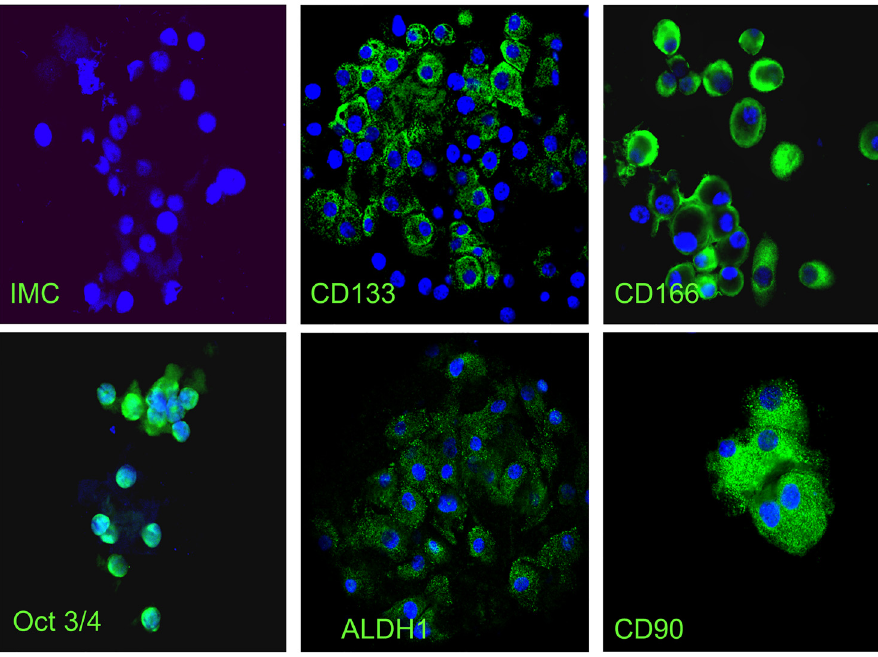
Fig 2. Phenotypical characterization of immature tumor cells isolated from tumor samples with immunofluorescence assay. The following panel of images refers to the characterization of cells isolated from the sample of a patient enrolled in the study. Green labelling is typical of positive cells. All markers of stemness (CD133, CD166, Oct 3/4, ALDH1, CD90) are positive in this CSC sample.